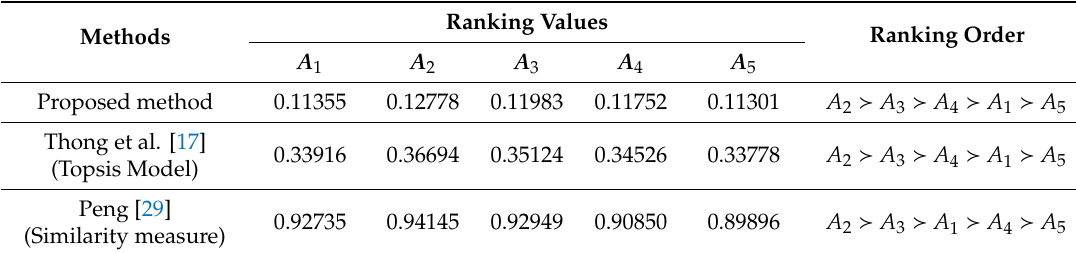
Table 6. A comparison study with some existing